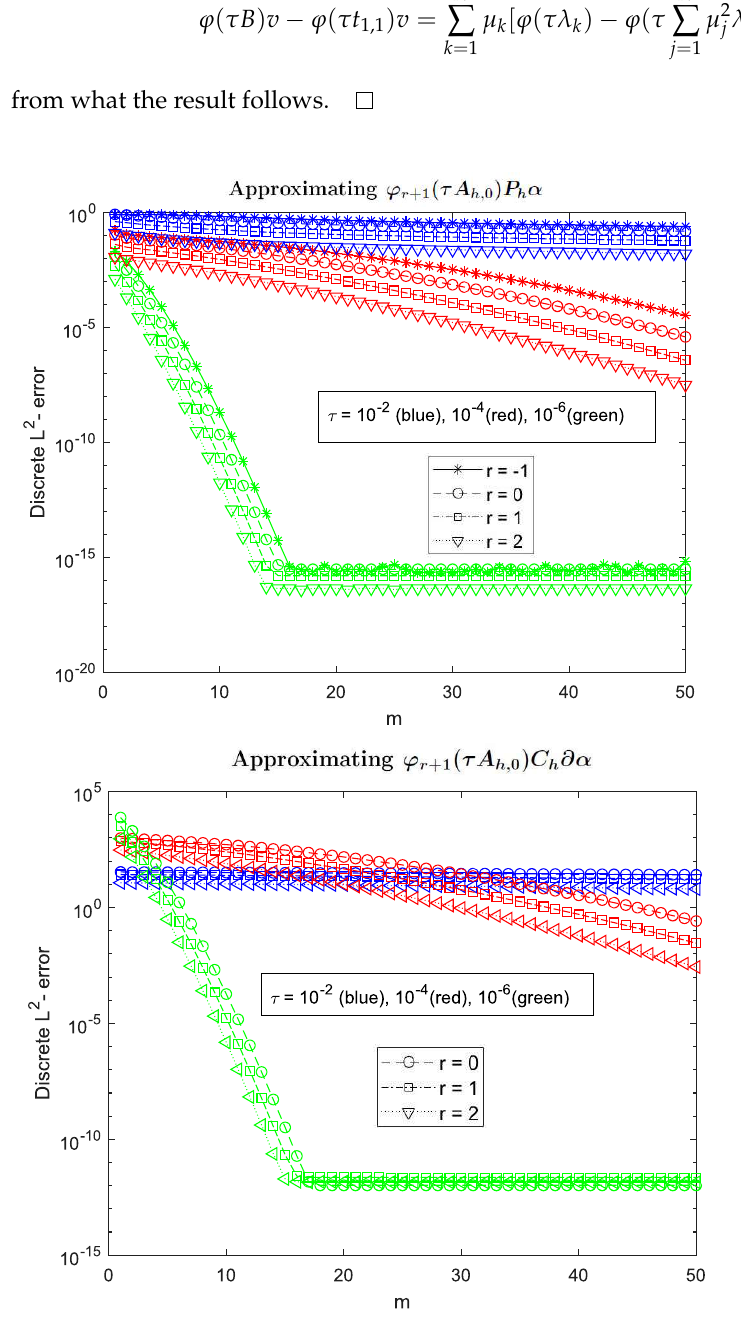
Figure 1. Discrete L 2 -error against number of Krylov iterations when approximating ϕ r + 1 ( τ A h ,0 ) P h α ( top ) and ϕ r + 1 ( τ A h ,0 ) C h ∂α ( bottom ) through standard Krylov method for different values of τ , r = 0,1,2 and fixed h = 10 − 3